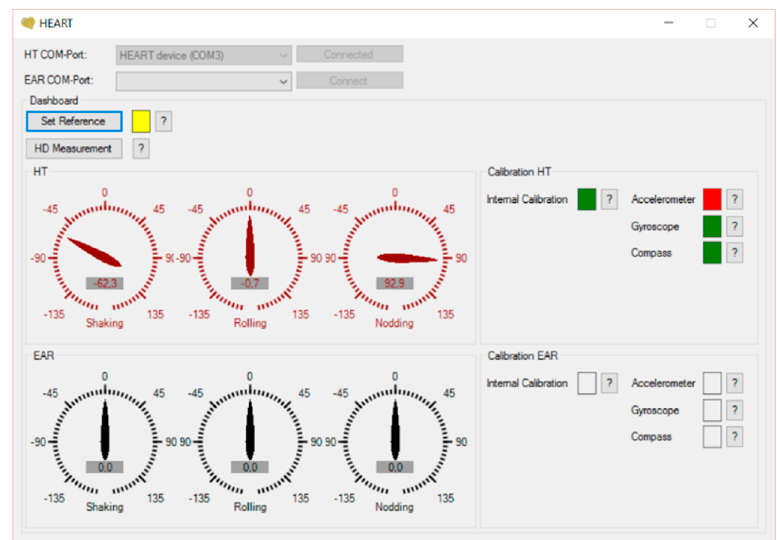
Figure 4. A snapshot of the software developed for the proposed head tracking system.